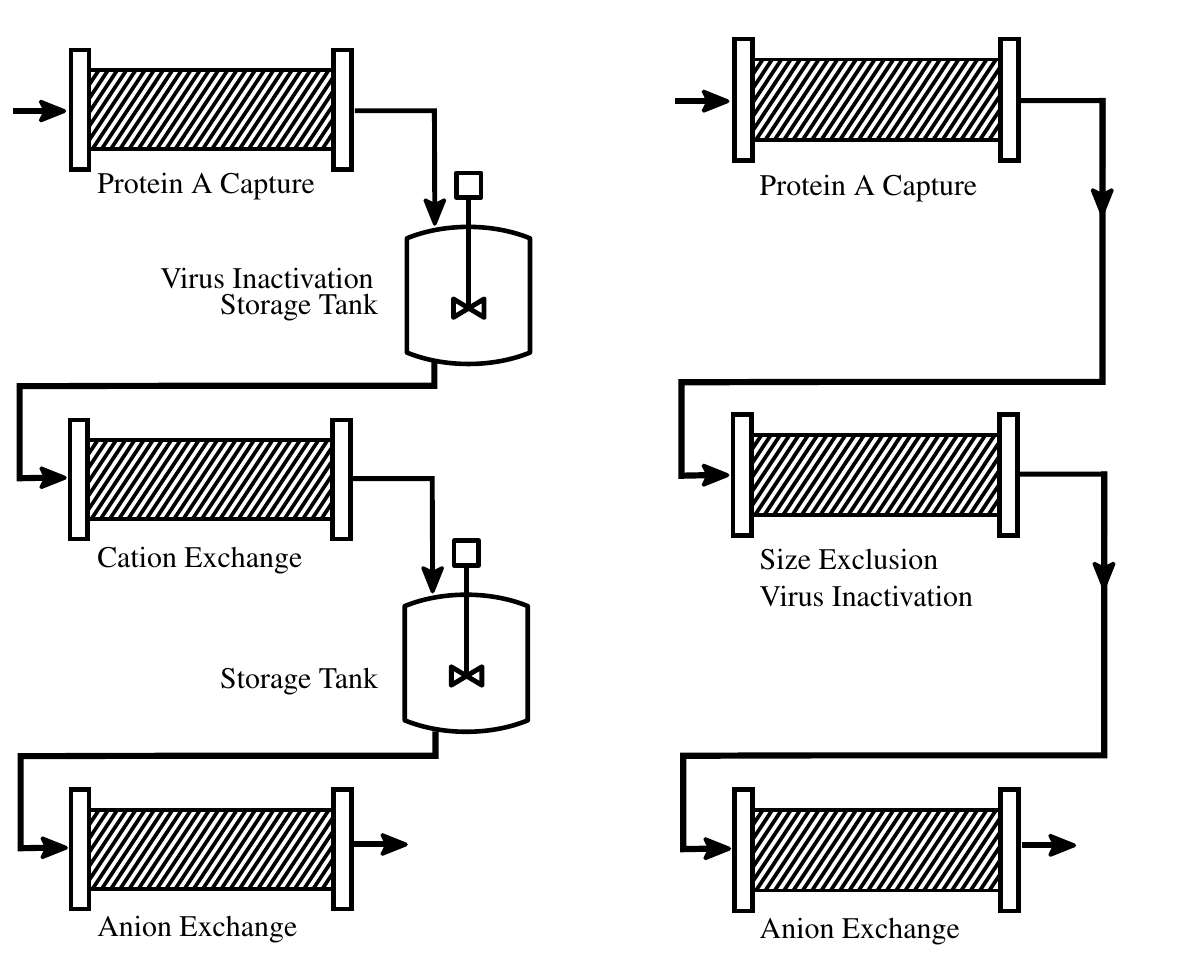
Figure 1. A batch-wise process is shown on the left and a continuous process on the